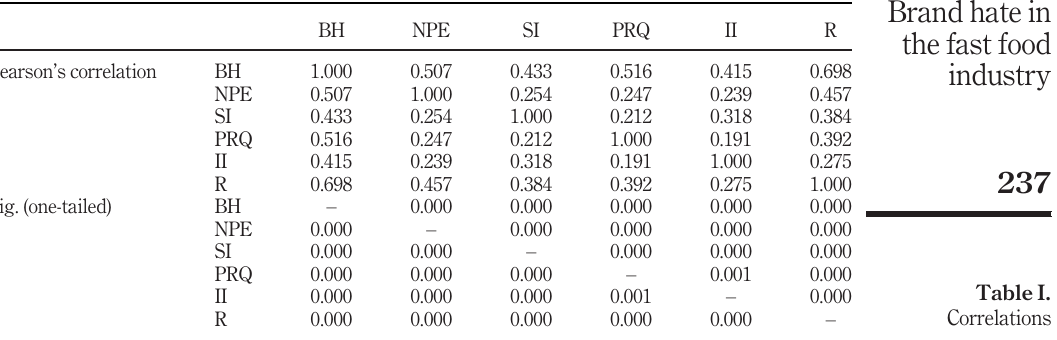
Table I. Correlations